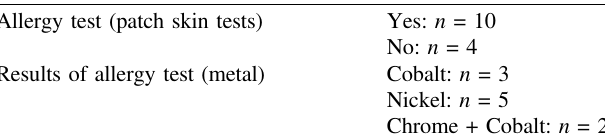
Table 1. Results of metal allergy